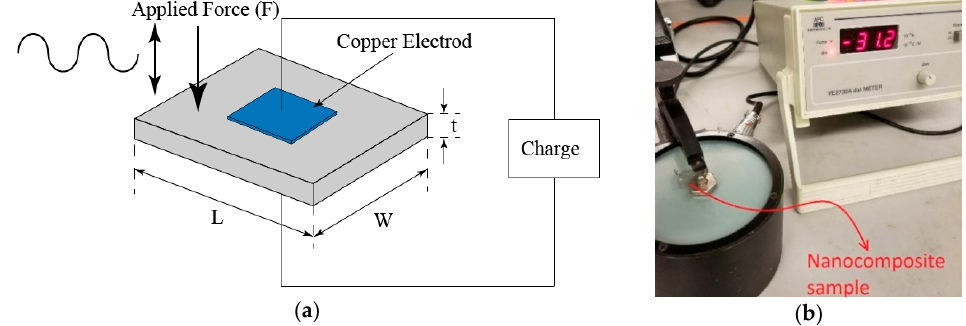
Figure 6. ( a ) Schematic of the piezoelectric coefficient ( d 33 ) measurement; ( b ) measured piezoelectric coefficient ( d 33 ) of the stretched sample after poling.